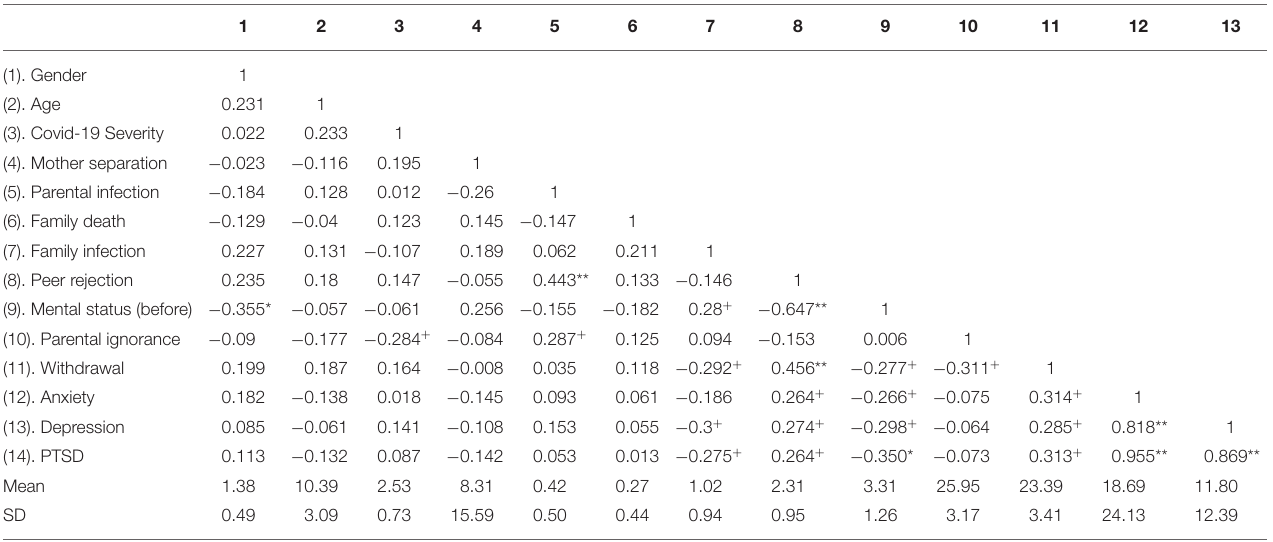
TABLE 2 | Observed zero-order correlations between